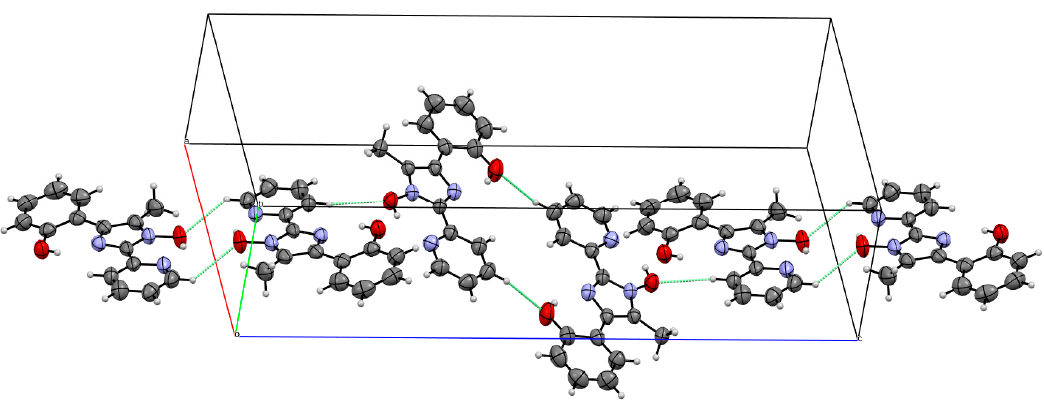
Figure 2. A supramolecular ribbon in the structure of L OH,OH .